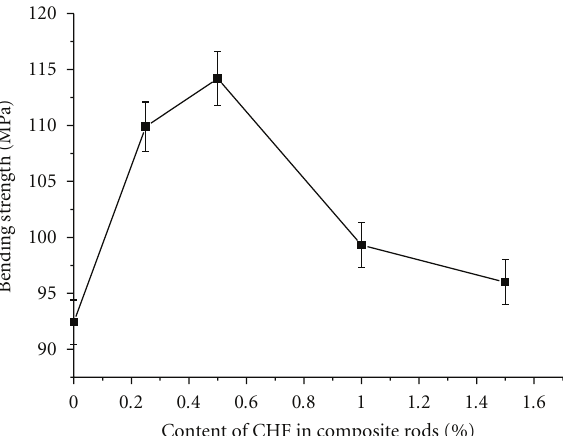
Figure 7: TG curves for (a) CS rod, (b) CHF, (c) CHF/CS (0.25/100, wt/wt), (d) CHF/CS (0.5/100, wt/wt), and (e) CHF/CS (1/100, wt/wt), in the 50–600 ◦ C temperature range under N 2 atmosphere.